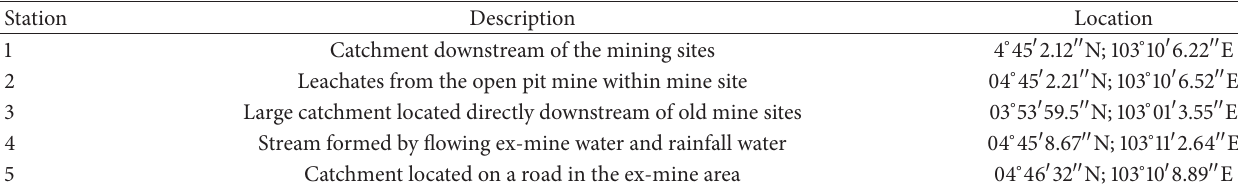
Table 1: The description and location of the sampling stations.